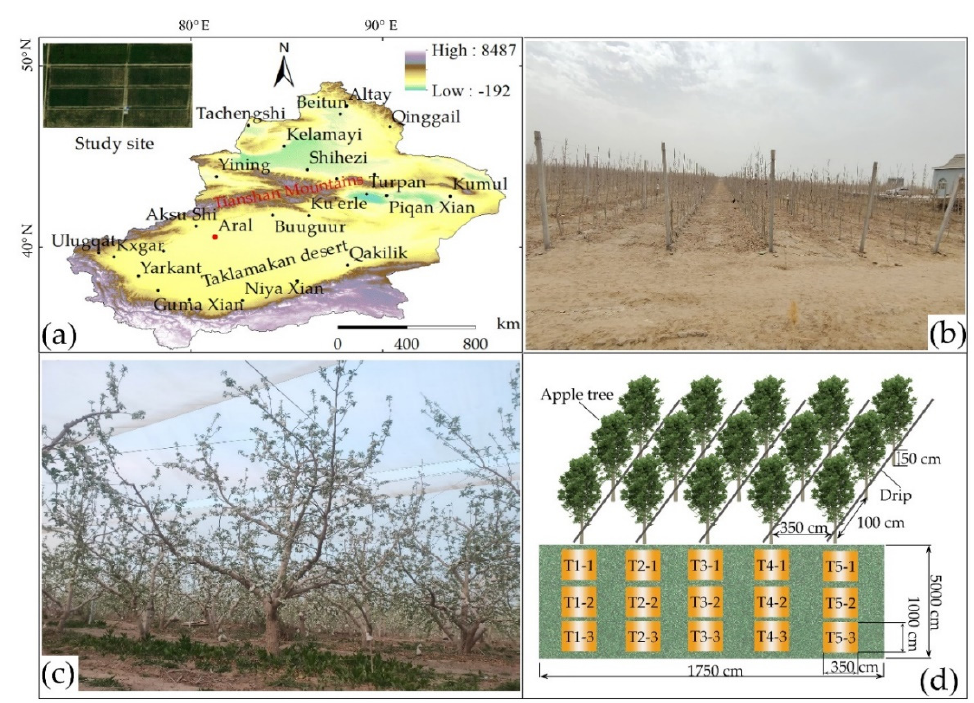
Figure 1. ( a ) Location of the experimental site; ( b ) an orchard of dwarf cultivation with high density of apple trees; ( c ) an orchard of arborized apple trees; ( d ) layout of experimental plots.